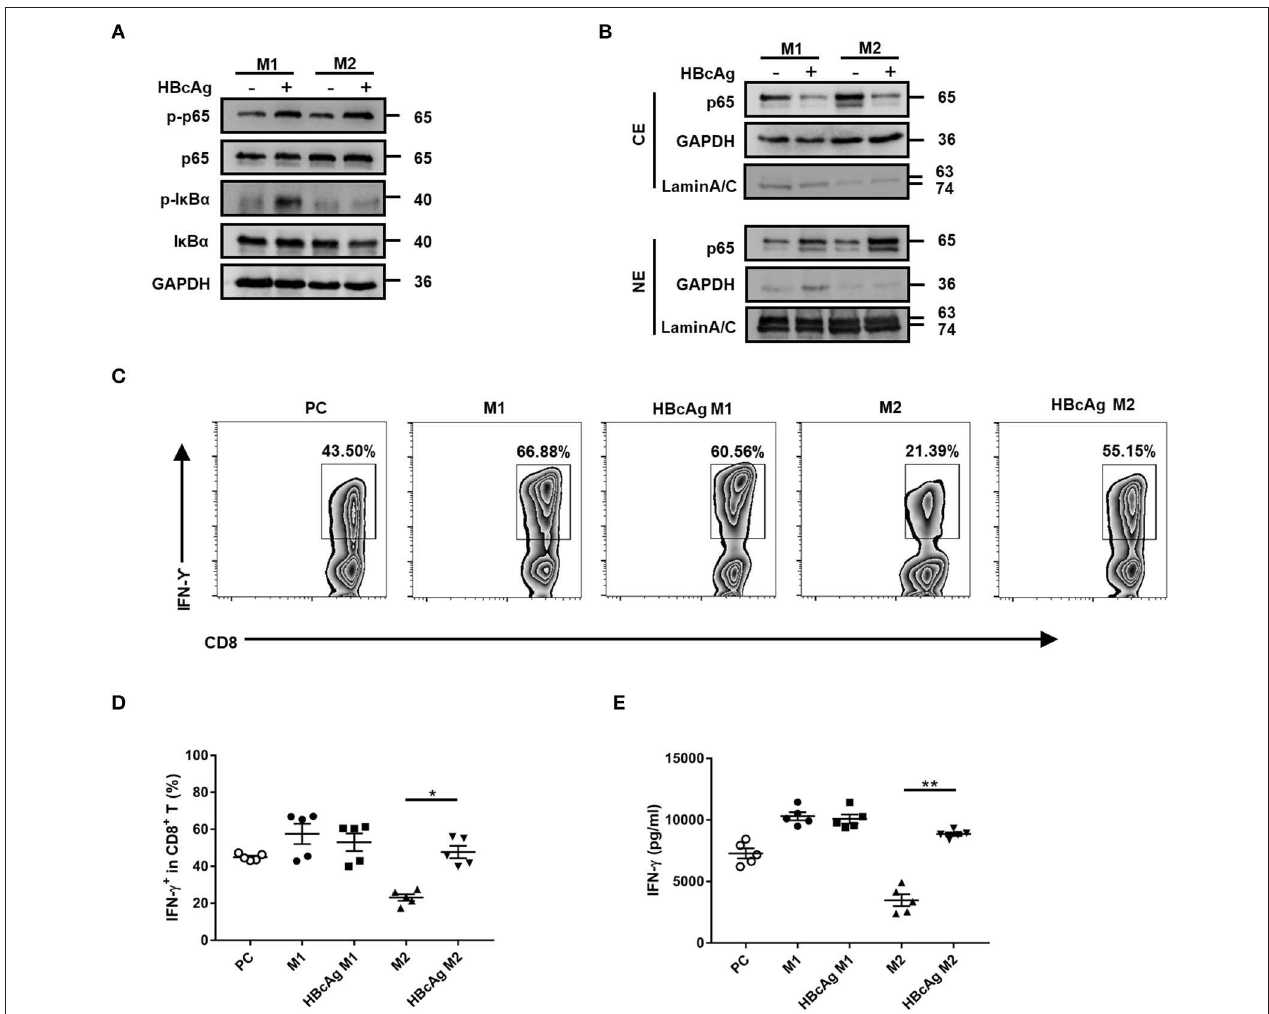
FIGURE 6 | HBcAg-responsive M2 macrophages exhibited the NF- κ B pathway activation and mediated CD8 + T cell activation. (A,B) After being stimulated with GM-CSF or M-CSF for 6 d, M0–M1 and M0–M2 unpolarized M Φ were incubated with LPS/IFN- γ or IL-4 further differentiation. After another 24h incubation, polarized M1 or M2 M Φ were stimulated with 10 µ g/ml HBcAg or an equal volume of PBS for another 30min. The protein levels of NF- κ B p65, p-NF- κ B p65, I κ B α , and p-I κ B α were analyzed by Western blot. Representative figures of total protein levels (A) and separated cytosol and nuclear protein levels (B) were shown. (C–E) 1 × 10 5 freshly purified autologous CD8 + T cells were coculture alone or with 5 × 10 4 polarized M1 or M2 macrophages (stimulated with HBcAg or not) in the presence of 3 µ g/ml anti-CD3/anti-CD28 Abs for 3 d. (C) Representative flow cytometric graphs and (D) cumulative results showing the amount of IFN- γ -producing CD8 + T cells. (E) Supernatants of cocultured CD8 + T cells were collected to measure IFN- γ production by ELISA. Experiments in (A,B) were repeated at least three times. Data were analyzed using a paired Student’s t -test. Results are shown as the mean ± SEM ( C–E , n = 5). * p < 0.05, ** p <